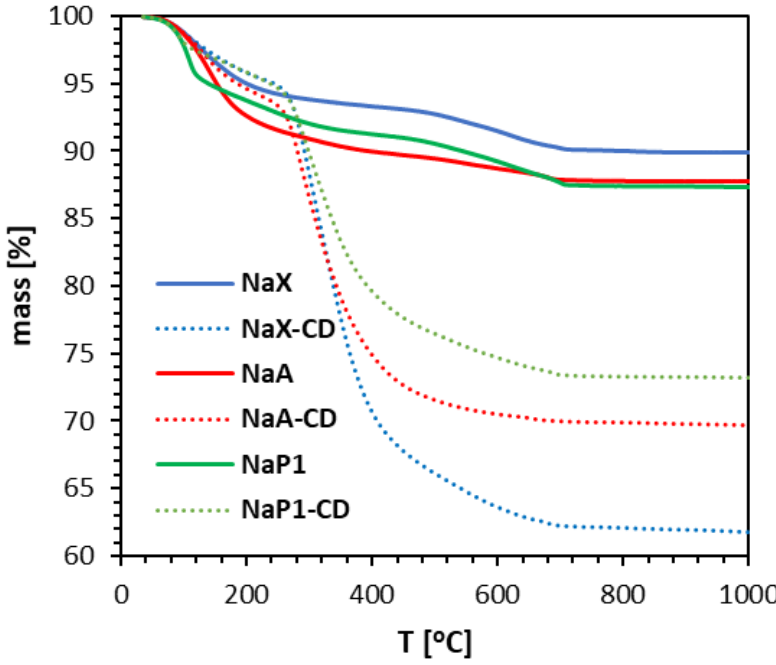
Figure 1. TG curves of zeolites NaX, NaA, and NaP1 before and after modification with β -CD. Mineral composition of the materials is presented in Figure 2 (left column). All the zeolites were composed of mineral phases attributed to NaX, NaA and NaP1 types, accompanied by some traces of mullite, quartz and amorphous glassy phase recognized by the characteristic rise in the background line in the angular range 15–35 ◦ 2 θ